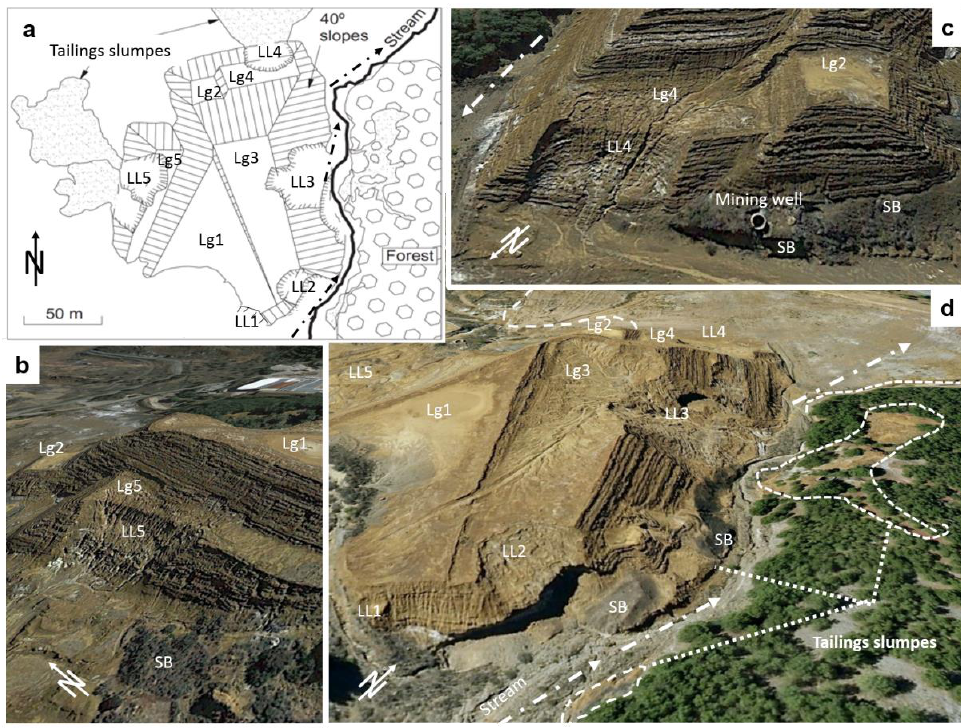
Figure 2. ( a ) Layout of El Descargador tailings dam depicting the localization of different landslides (LL), lagoons (Lg), and fragments of breakwater (SB) and some are affected for flow failure. The discontinuous arrow indicates the direction of the runoff, ( b – d ) Obliquus aerial views of the dam from different perspectives; source Spanish National Geographic Institute-IGN and Google Earth© .